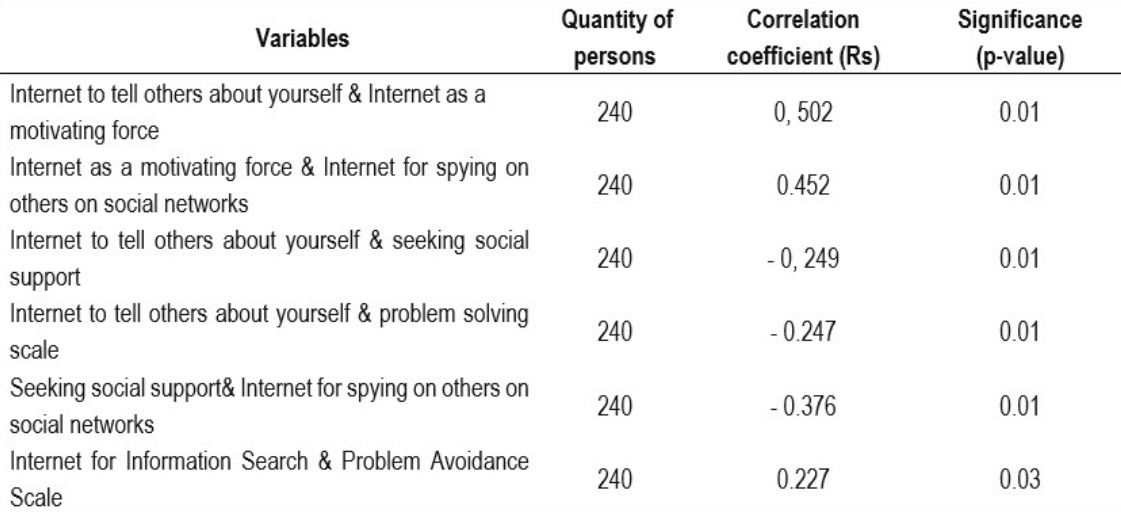
Results of correlation analysis between motivational strategies of informational behavior and strategies of coping behavior